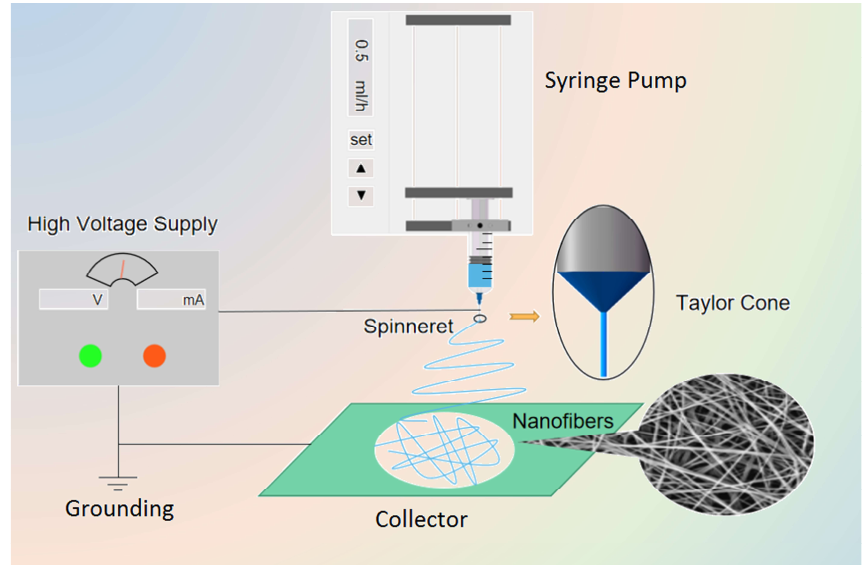
Figure 3. Diagram of electrospinning device.